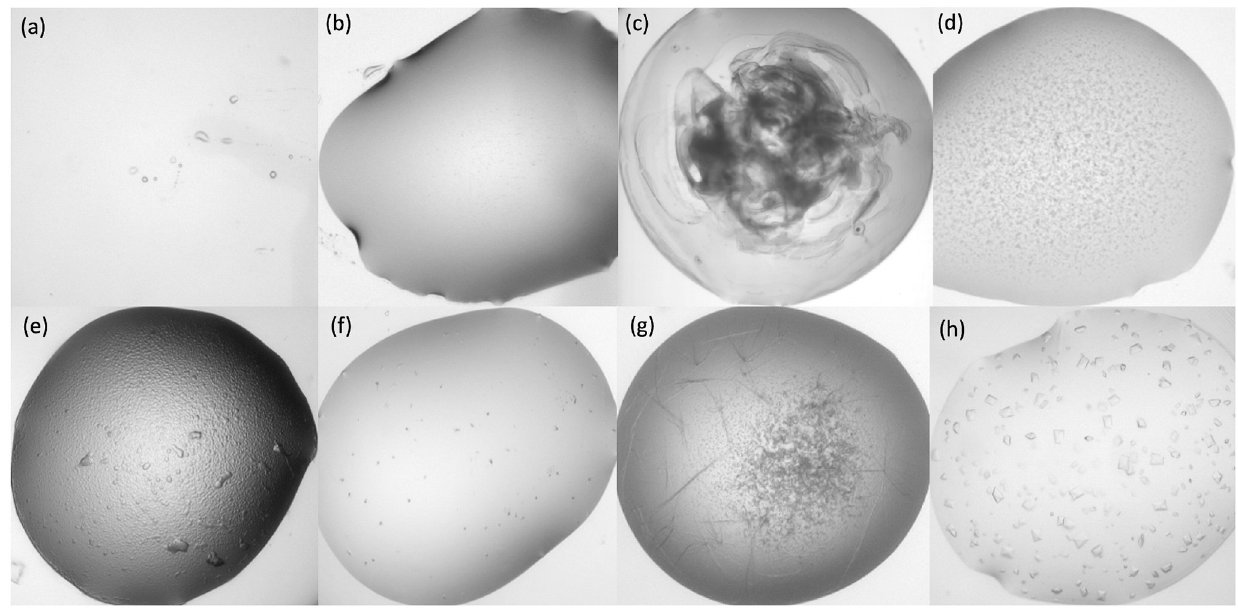
Fig 1. Example images from each class. (a) shows a null image in which no drop has been dispensed;(b) shows a clear drop;(c) shows heavy precipitate where the protein is denatured;(d) shows light precipitate ; (e) shows phase separation ; (f) shows crystalline material; (g) shows optimisable crystals and (h) shows shootable